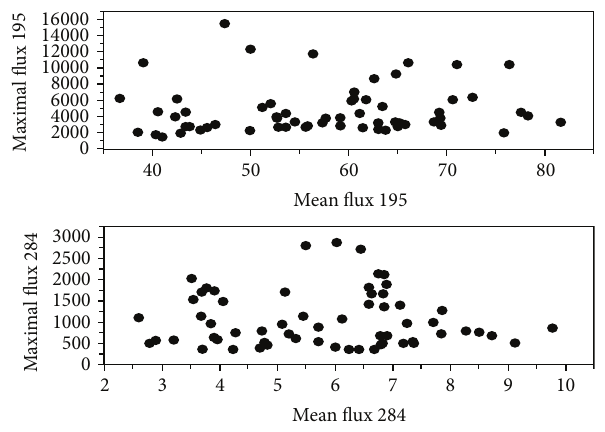
Figure 2: Comparison of the maximum and mean brightness